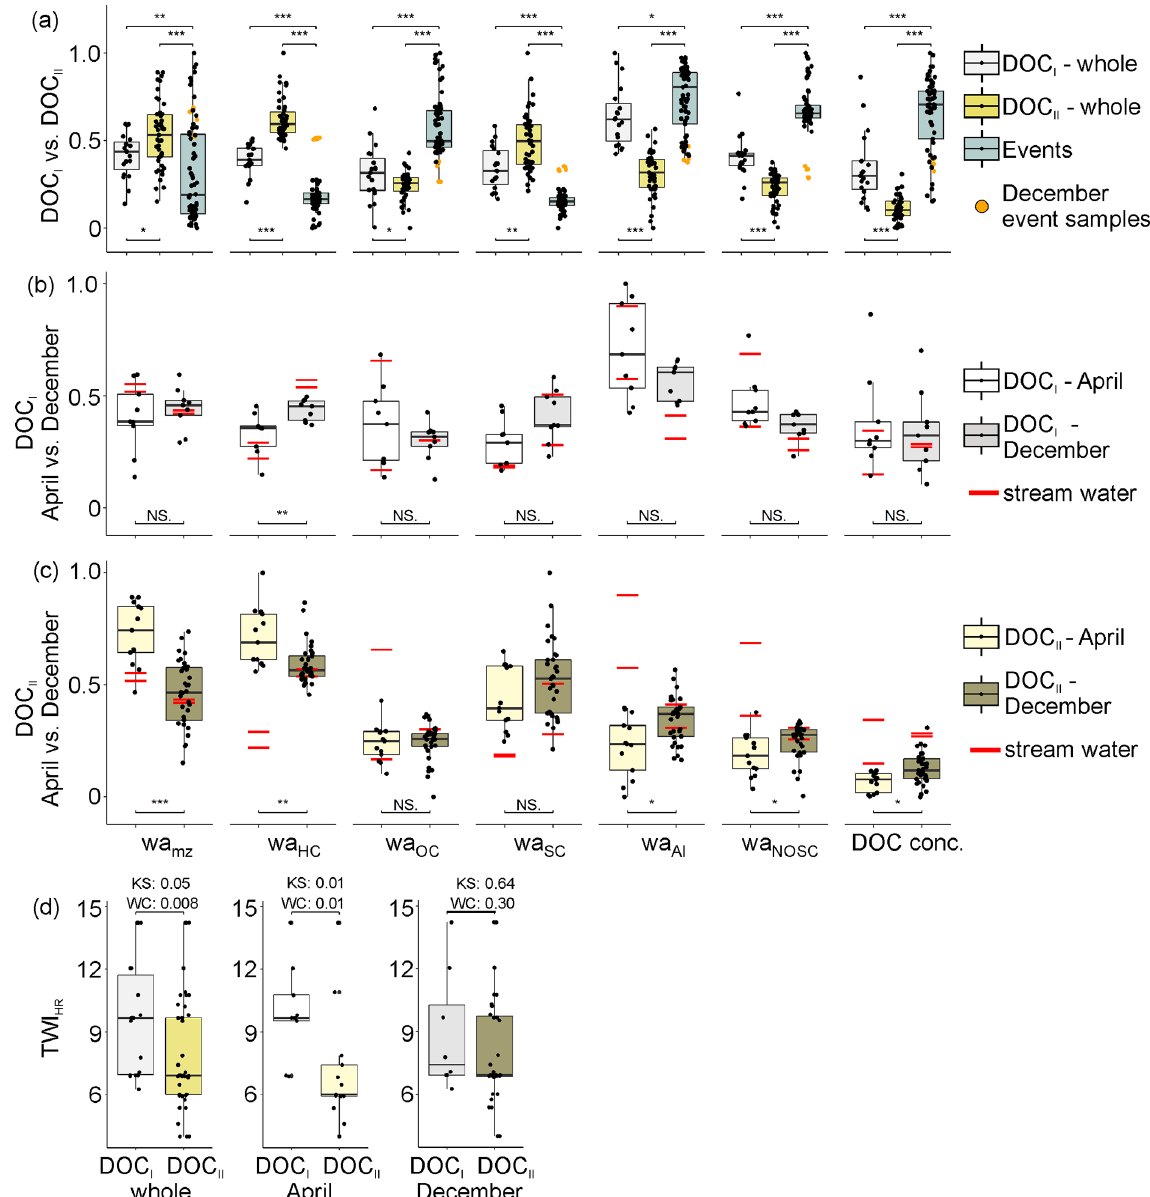
Figure 4. Comparison of FT-ICR-MS-derived weighted average (“wa”) molecular parameters wa mz (mass to charge ratio), wa HC (hydrogen to carbon ratio), wa OC (oxygen to carbon ratio), wa SC (sulfur to carbon ratio), wa AI (aromaticity index) and wa NOSC (nominal oxidation state of carbon) as well as DOC concentration (DOC conc.) and high-resolution TWI (TWI HR ) values of stream, DOC I and DOC II samples. (a) Boxplots of molecular parameters and DOC concentration of the DOC I and DOC II clusters. Orange dots indicate samples of one December event. (b) Boxplots of molecular parameters and DOC concentration of April and December DOC I samples and all event samples. (c) Boxplots of molecular parameters and DOC concentration of April and December DOC II samples and all event samples. Red horizontal lines in panels (b) and (c) indicate weighted averages of two April and two December stream water samples collected during the respective riparian groundwater sampling campaign. Data in panels (a–c) were min–max normalized to values between 0 and 1 for better illustration (see Table 1 for actual values). (d) Boxplots of TWI HR values as affiliated to the respective wells of DOC I and DOC II samples. Wilcoxon rank sum (WC) and Kolmogorov–Smirnov (KS) test results are depicted above the squared brackets. Squared brackets above and below boxplots in (a–c) indicate the application of a KS test between two partitions. Asterisks indicate p values of the KS test ( ∗∗∗ : < 0 . 001; ∗∗ : < 0 . 01; ∗ : < 0 . 05; NS: not